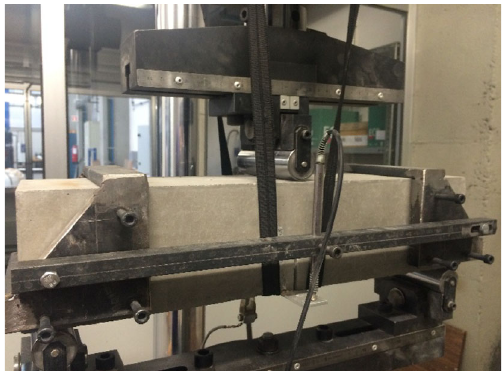
Fig. 9 Three-point bend test of prismatic notched specimens with weight